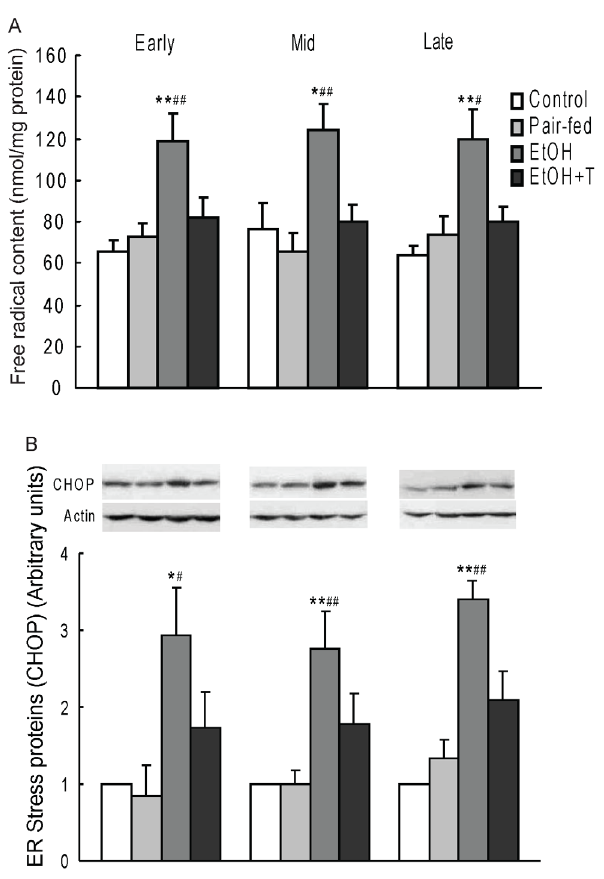
Figure 7. Hepatic cytosol free radical level (A) and ER stress protein (CHOP) level (B) in 4 month-old male rat offspring exposed to ethanol (EtOH) or water only during early, mid, or late pregnancy. Control and pair-fed offspring were from dams with free access to chow and dams fed the amount of chow consumed by EtOH dams, respectively. A subgroup of EtOH rats was given TUDCA (T) 3 weeks before the experiments. Data are the mean 6 SE, n=6. *P , 0.05, **P , 0.01 EtOH vs. control; # P , 0.05, ## P , 0.01 EtOH vs.